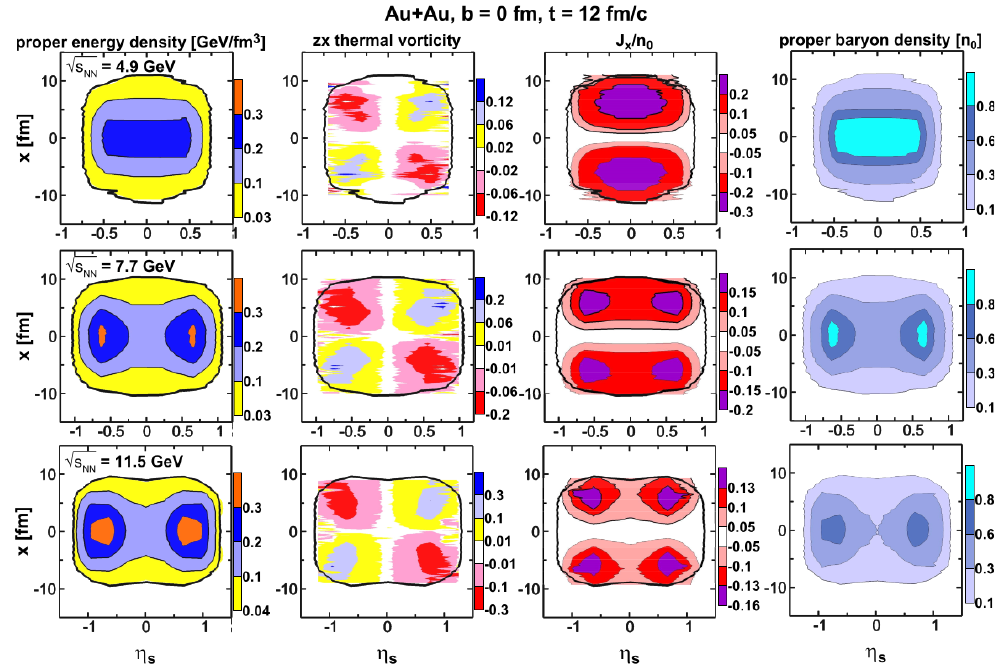
Figure 5. Columns from left to right: the proper energy density (GeV/fm 3 ), the proper-energy- density-weighted relativistic thermal zx vorticity, x -component of the baryon current ( J x ) in units of normal nuclear density ( n 0 = 0.15 1/fm 3 ), and the proper baryon density ( n B ) in units of n 0 in the x η s plane at time instant t = 12 fm/c in the ultra-central ( b = 0 fm) Au+Au collisions at √ s NN = 4.9–11.5 GeV. η s is the space–time rapidity along the beam ( z -axis) direction. Calculations are performed with the crossover EoS. The bold solid contour indicates the border of the nuclear matter with n B > 0.1 n 0